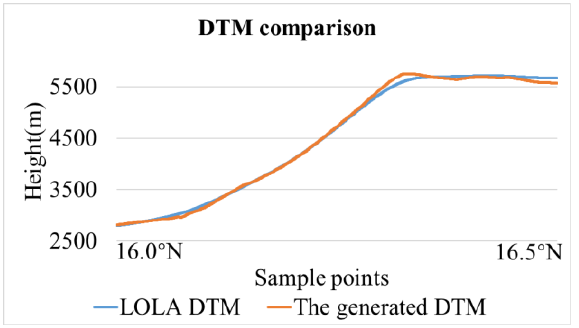
Figure 5. The terrain profiles comparison between the generated lunar DTM and LOLA DTM